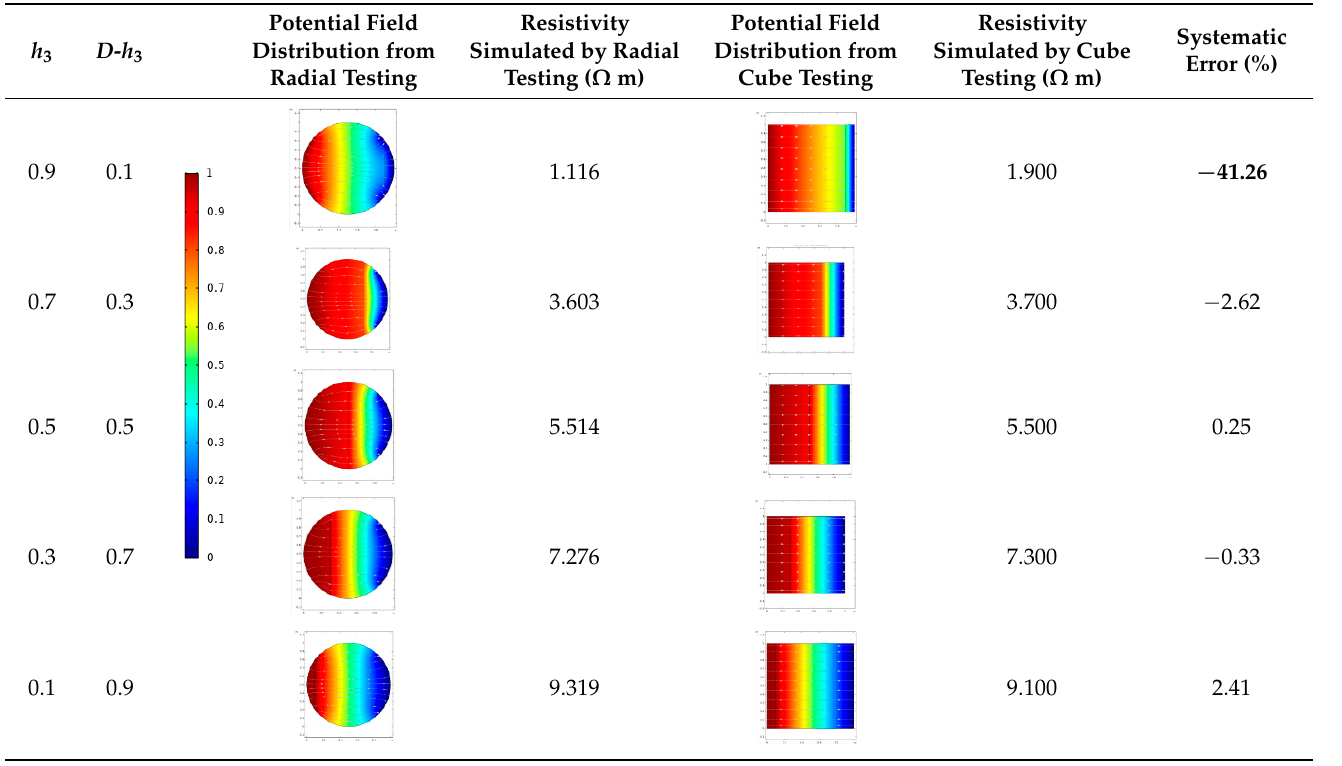
Table 2. Extreme 3: numerical simulation results of different material thicknesses.